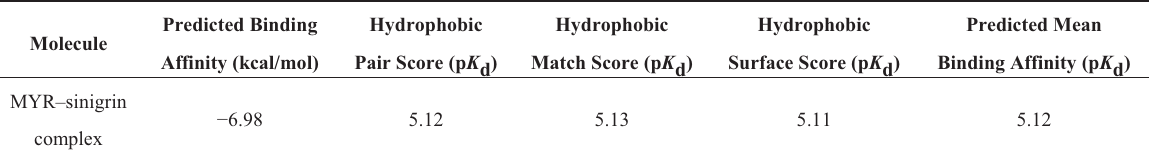
Table 2. The bonded and non-bonded interaction scores of MYR–sinigrin complex after 20-ns molecular dynamics simulations. Scores were calculated using the X-score